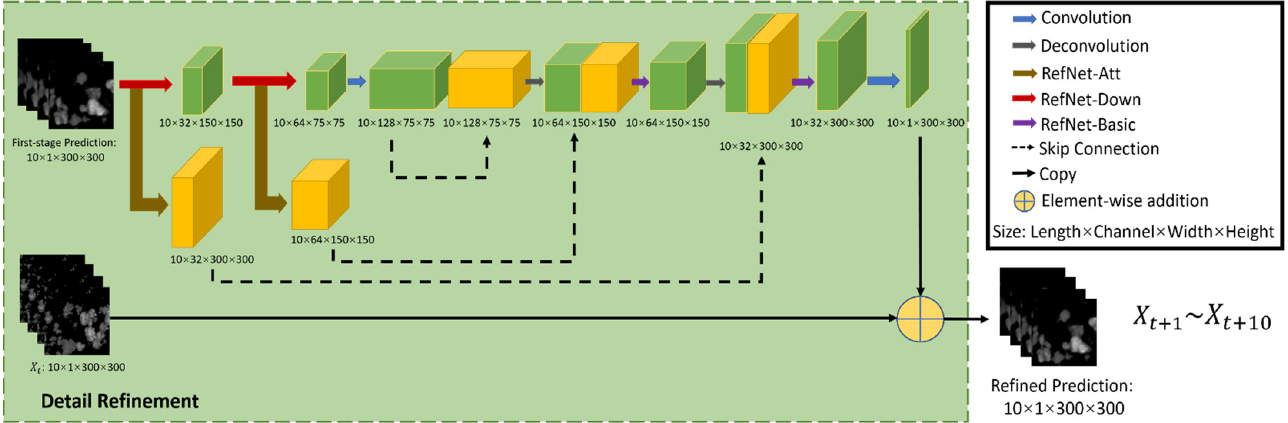
Figure 6. The overall architecture of the proposed RefNet. It mainly includes RefNet-Basic, RefNet-Att, and RefNet-Down modules.